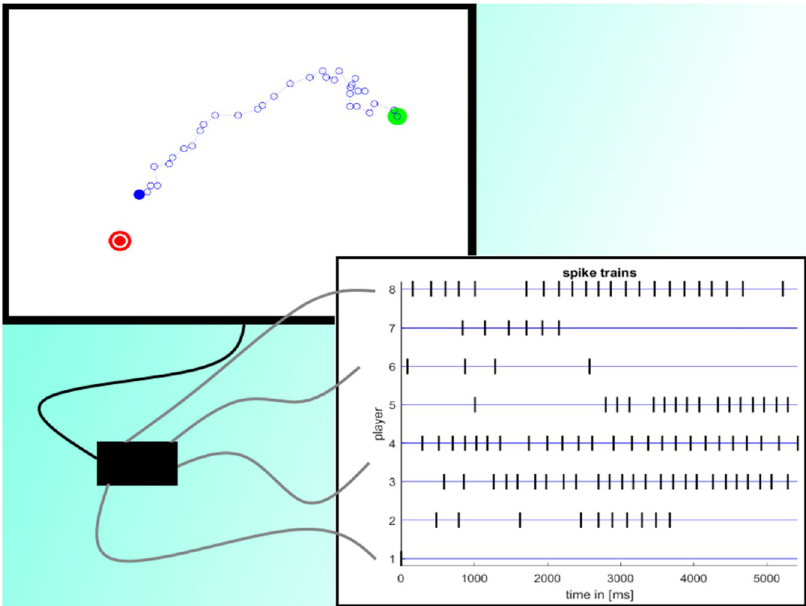
Figure 1. The NeuronGame. Participants sit in front of a shared screen and have to cooperate in order to steer a cursor (solid blue circle) from a start (green circle) to a goal position (red circle). Each player is assigned an unknown movement direction such that a button press of that player moves the cursor with a small step into that direction. Players are not allowed to communicate, so the difficulty is for each player to figure out their movement direction while the entire group is playing. In each instance of time each player has to decide whether to be active or inactive, this way, generating a spike train of active events. The portrayed movement pattern (blue-rimmed circles) is a typical example extracted from the experiment. Near the start, within the first two to three seconds of the level when all players try to learn the effect of their actions, the cursor’s movement seems to be erratic. As soon as players gather an adequate amount of information, some players (in the example player 1, 6, 7, 2) stop spiking while the remaining players proceed to refine the